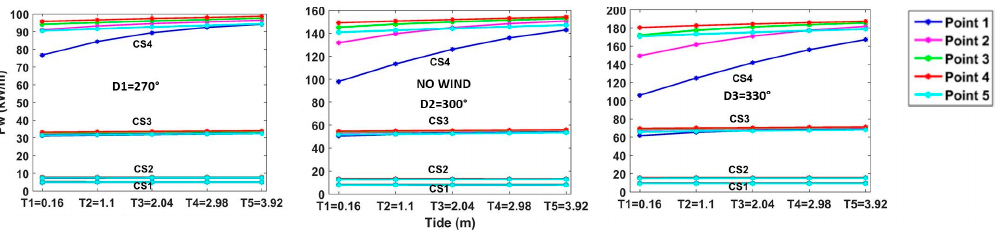
Figure 13. No ‐ wind conditions: wave power ( P w ) variations along the reference points corresponding to the three different directions of the incoming waves (D1, D2, D3) and to the five tide conditions (T1, T2, T3, T4, and T5) for all the case studies considered (CS1, CS2, CS3, CS4). Table 6. SWAN results for CS3, corresponding to the reference points P3, P4, and P5, the tide levels T1 and T5, and the wind conditions W0, W7, and W22, in terms of the wave parameters H s , H sw , and P w . CS3